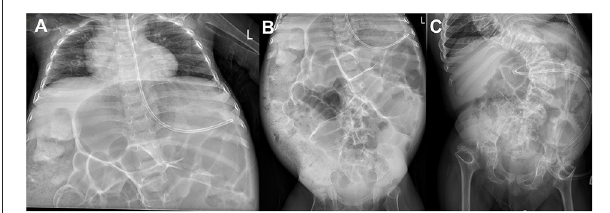
FIGURE 5 | Abdominal X-rays of patients 1 and 3. (A,B) Patient 3 at age 2 years; severe dilatation of the stomach and bowel loops and fecal impaction especially in the right colon. (C) Patient 1 at age 8 years; a similar stomach and bowel loop dilatation.